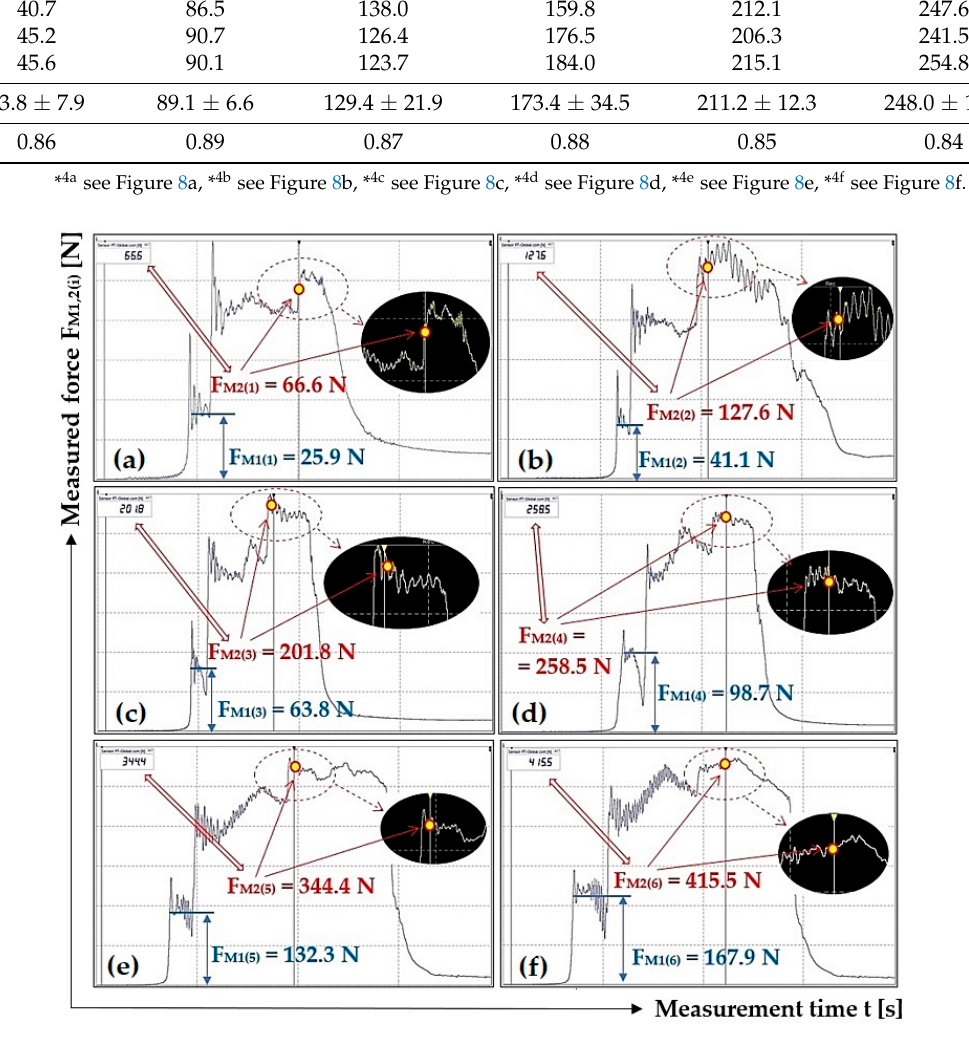
Table 5. Measured force F M1(i) [N] and F M2(i) [N] for the weight of the load G b(i) [N] at angle β = 30 deg.